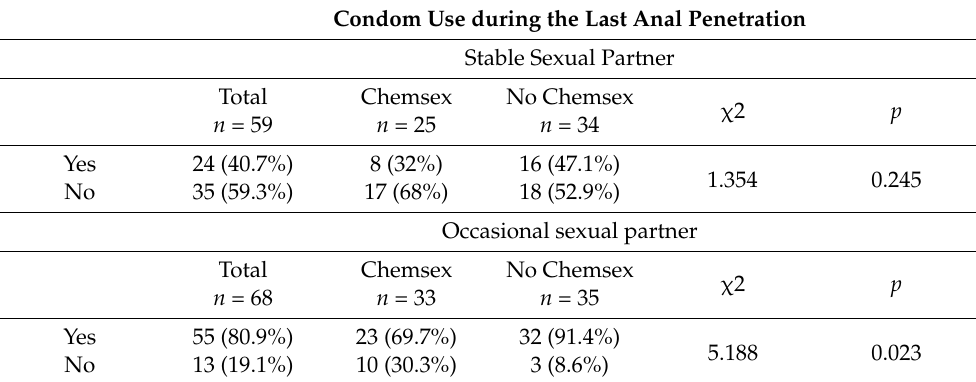
Table 4. Condom use during the last anal penetration with stable and occasional sexual partners.